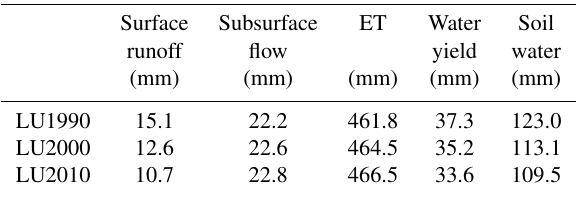
Table 4. Simulated average annual values of hydrological compo- nents in the Yanhe Basin under different land use conditions.